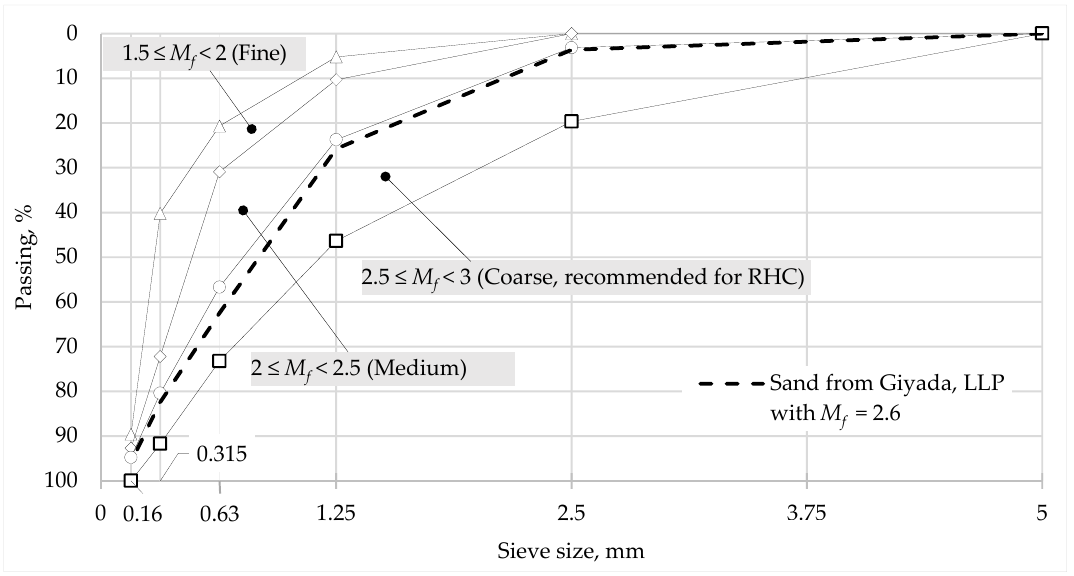
Figure 1. Sieve analysis grading curve for fine aggregate [22].